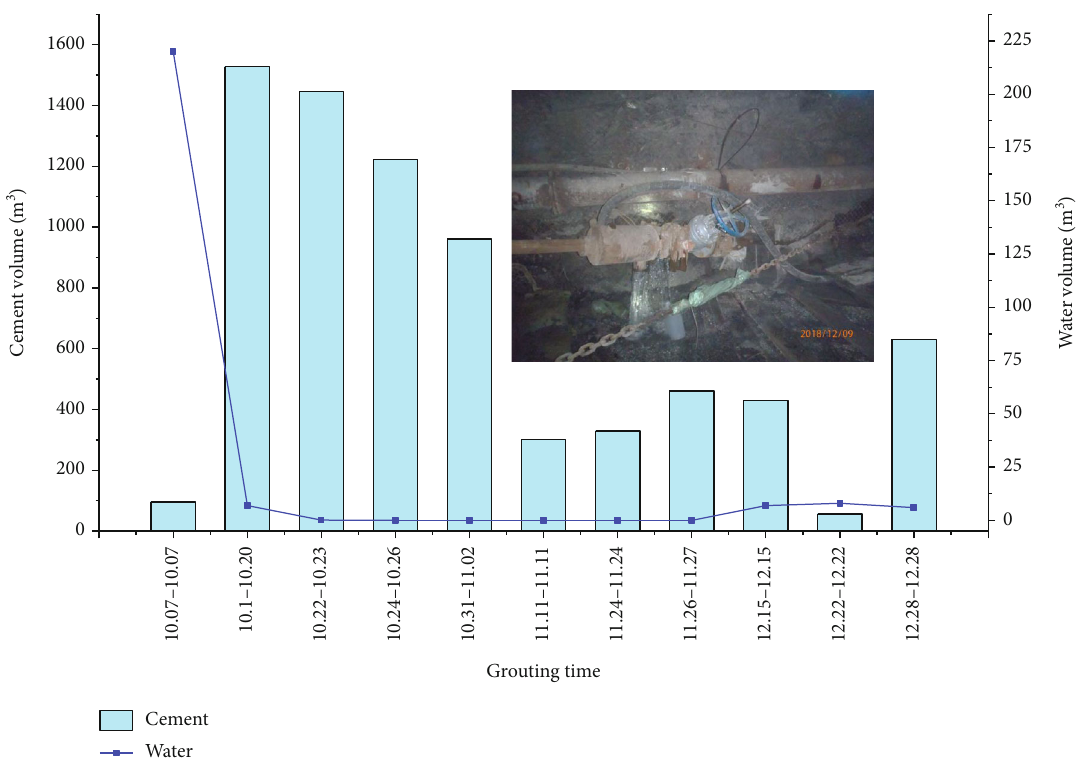
Figure 11: Grout cement and water